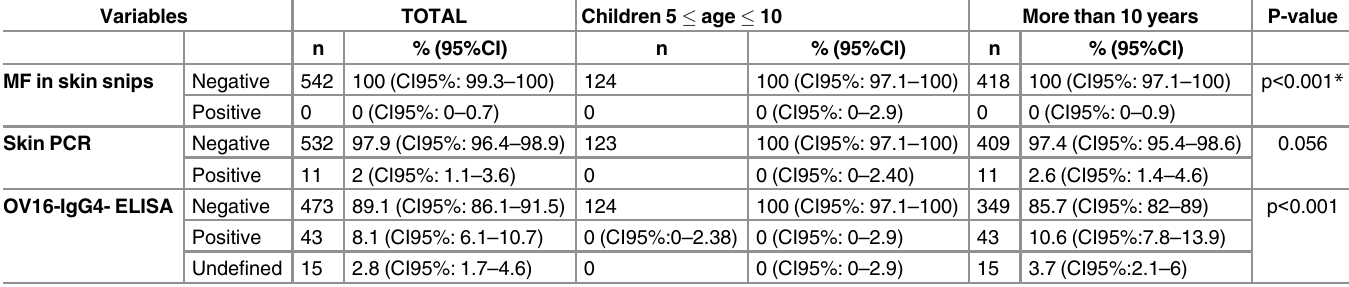
Table 3. Laboratory assessments, Bioko Island, January